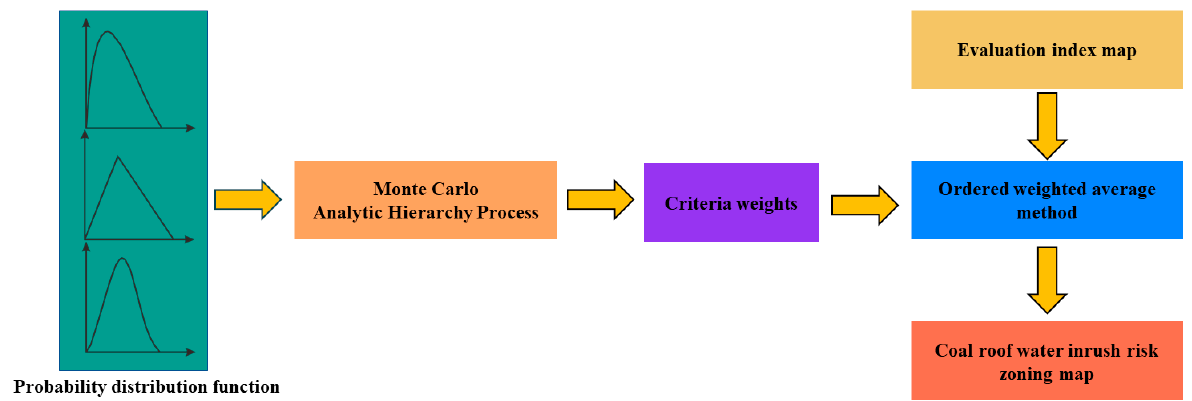
Figure 3. Probabilistic spatial multicriteria decision framework.